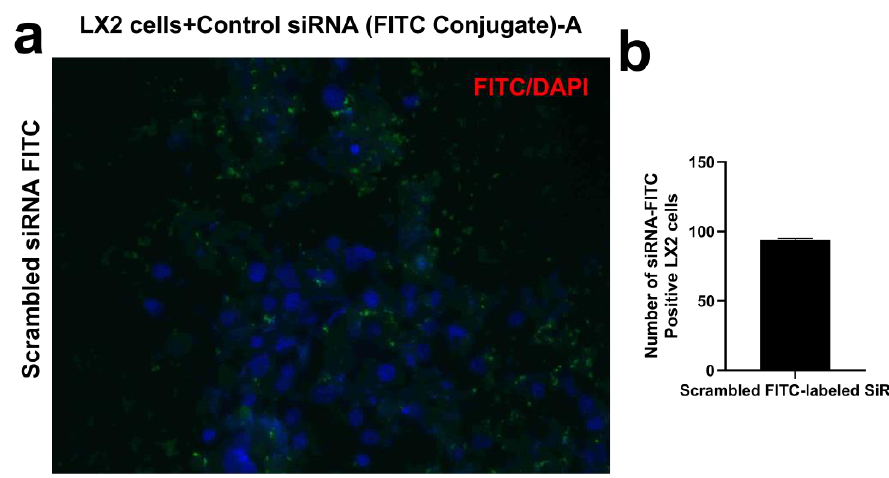
Figure 9. Transfection of LX2 cells with siRNA. ( a )The transfection efficiency of LX2 cells was measured by quantifying the siRNA-scrambled FITC (green)-positive cells. Cells were visualized by a 20× Keyence microscope. The picture used is representative data from one out of three independent experiments. ( b ) Transfection efficiency quantification.